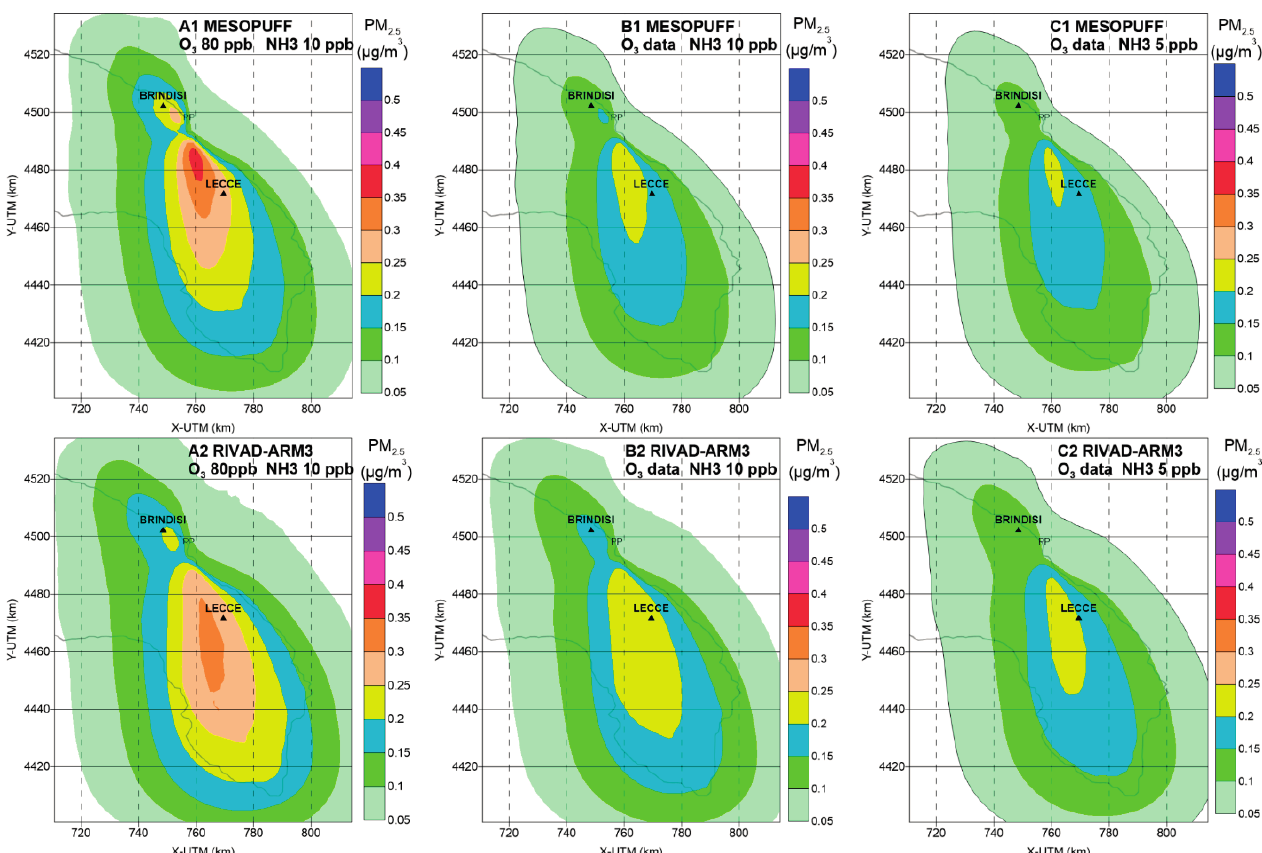
Figure 3. Estimated annual average secondary PM 2.5 concentrations (µg/m 3 ) for different Calpuff runs. Year